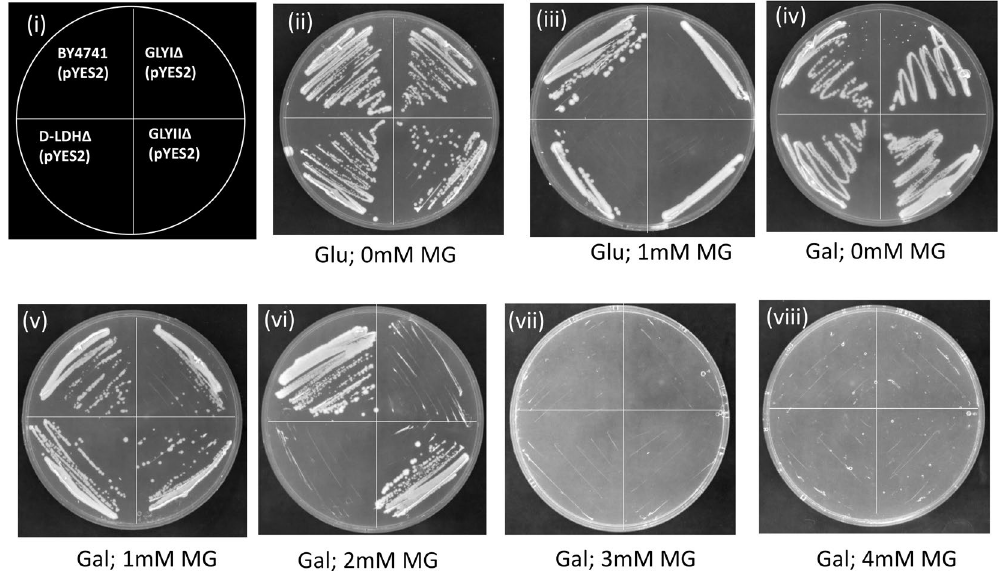
Figure 6. Loss of function study reveals role of different genes in MG detoxification: BY4741 wild type yeast cells, GLYIKO, GLYIIKO and D-LDHKO mutant yeast cells containing empty vector pYES2 were grown on Ura − SD agar plates with different supplements to check for their contribution to MG detoxification. ( i ) Pictorial representation of various strains used. ( ii ) Medium supplemented with 20% glucose. ( iii ) medium supplemented with 20% glucose and 1 mM MG. (iv ) Medium supplemented with 20% galactose. ( v ) Medium supplemented with 20% galactose and 1 mM MG. ( vi ) Medium supplemented with 20% galactose and 2 mM MG. ( vii ) Medium supplemented with 20% galactose and 3 mM MG. ( viii ) Medium supplemented with 20% galactose and 4 mM